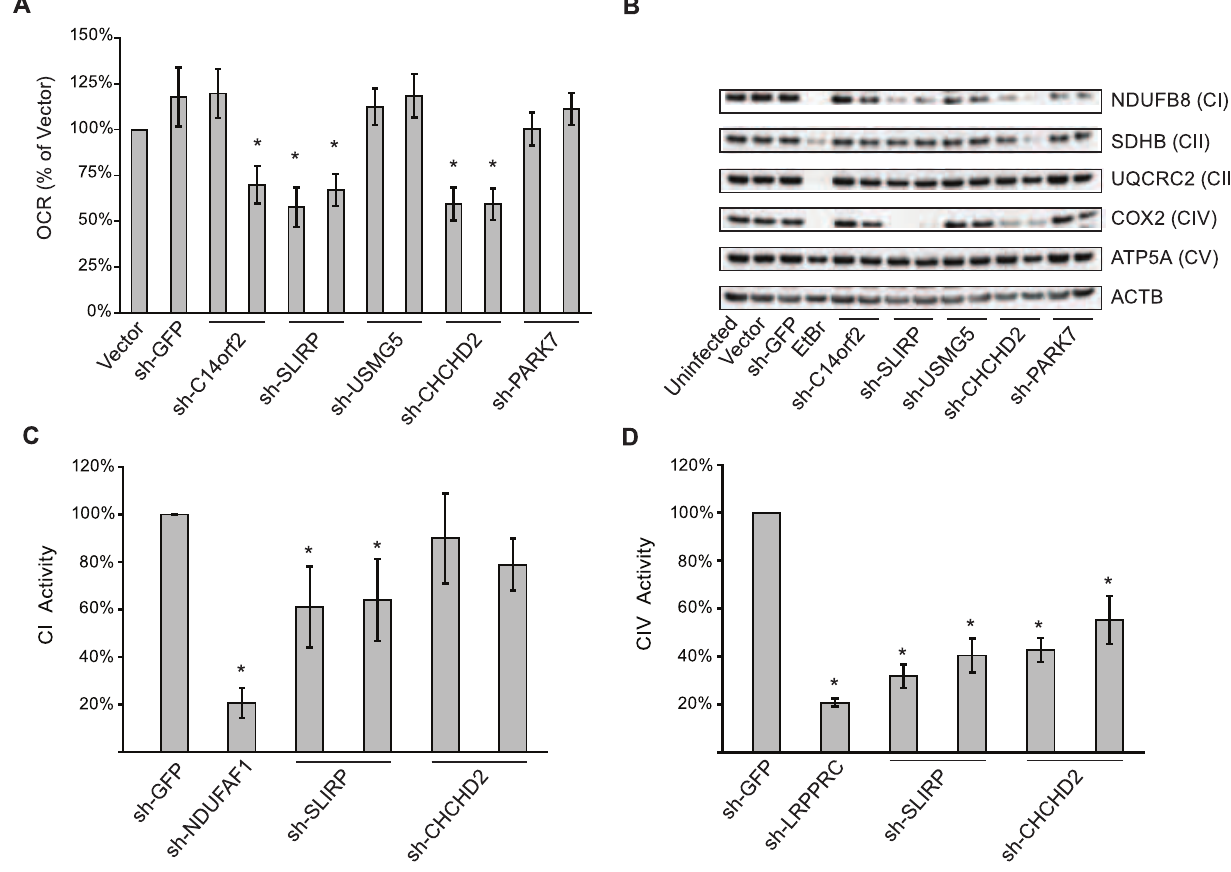
Figure 4. Silencing CHCHD2 and SLIRP disrupts OxPhos function. (A) Oxygen consumption rate (OCR) of MCH58 human fibroblasts measured at 10–14 days post-infection with empty vector, shRNA targeting GFP, or two independent shRNAs targeting each of five candidates from the OxPhos expression screen. Values are reported as percent of empty vector sample’s OCR and represent means of 20 replicate wells. Error bars indicate the 95% normal confidence interval. (B) Western blot of cleared whole cell lysate harvested 10–14 days post-infection, subjected to SDS-Page and blotted for labile markers of each OxPhos complex. shRNA targets are indicated below each lane and blotted proteins are indicated to the right with their respective OxPhos complex in parentheses. EtBr represents a positive control sample from cells treated with 40 ng/ml ethidium bromide for 4 days. (C, D) Assays for activity of complexes I and IV in whole-cell native protein harvested from MCH58 cells infected in triplicate with shRNAs targeting SLIRP , CHCHD2 (two independent shRNAs each) or GFP. Values are reported as percent of activity for shRNA targeting GFP. Error bars represent standard deviation. *, P , 0.05 (n=3, two-tailed unpaired t-test).